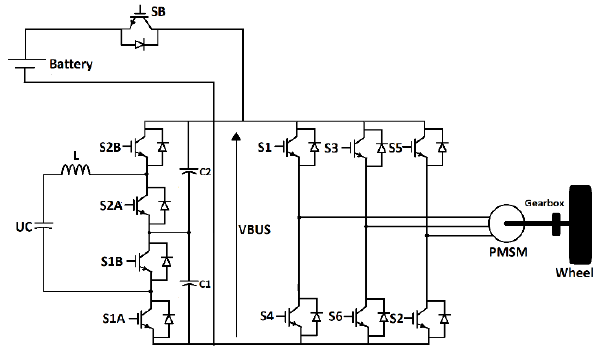
Figure 1. 3-Level DC/DC converter and SVPWM inverter in a semi-active topology.